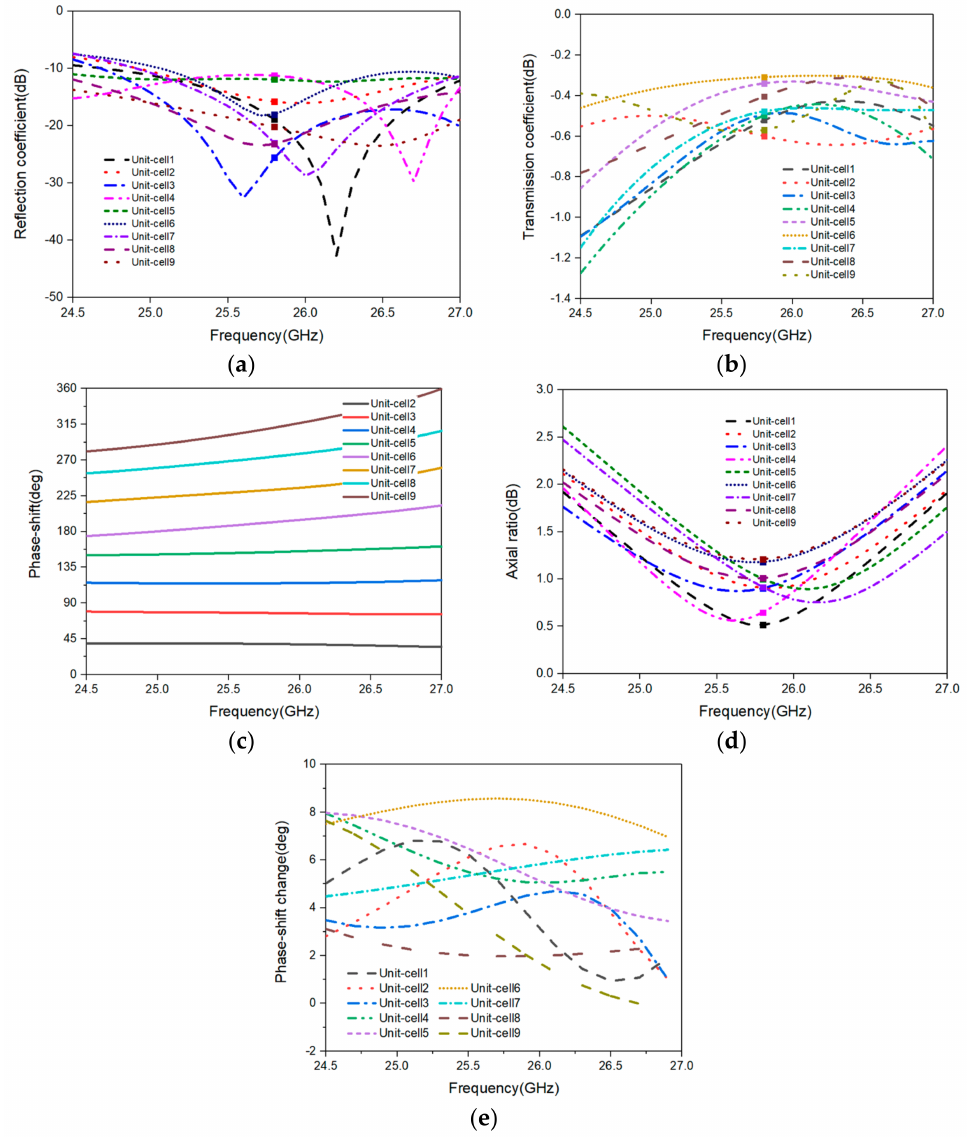
Figure 3. Phase modulation and polarization conversion properties of the proposed lens element over the frequency range 24.5–27 GHz: ( a ) reflection coefficient in dB; ( b ) transmission coefficient in dB; ( c ) phase shift in degrees; ( d ) axial ratio of the converted right-hand circular polarization in dB; ( e ) phase change for the incident wave varying from 0 degrees to 30